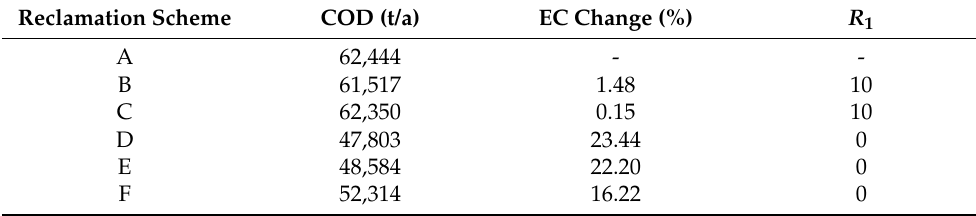
Figure 8. Computed region of marine EC (scenario 2). Computed region of plan A; computed region of plan B; computed region of plan C; computed region of plan D; computed region of plan E; computed region of plan F. Table 12. Feasibility evaluation in COD environmental